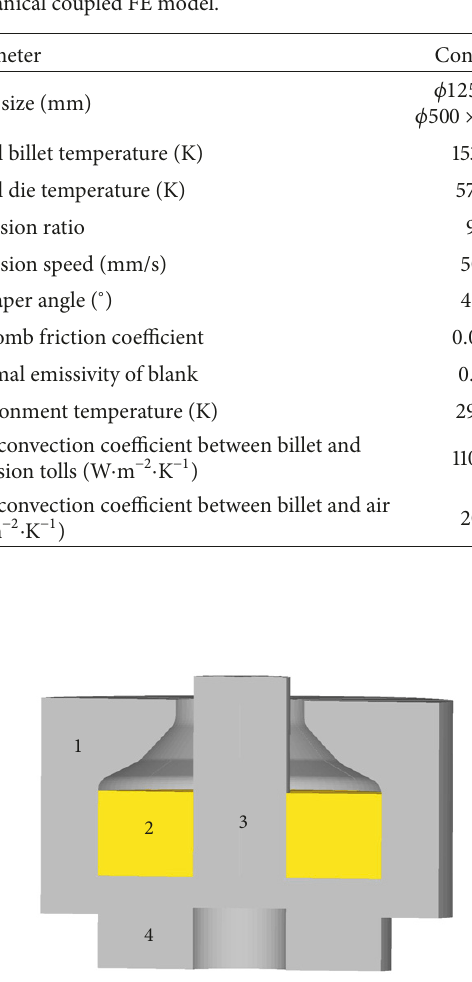
Figure 14: The geometric model of the hot extrusion process. 1: die; 2: as-cast billet; 3: extrusion needle; 4: terrace